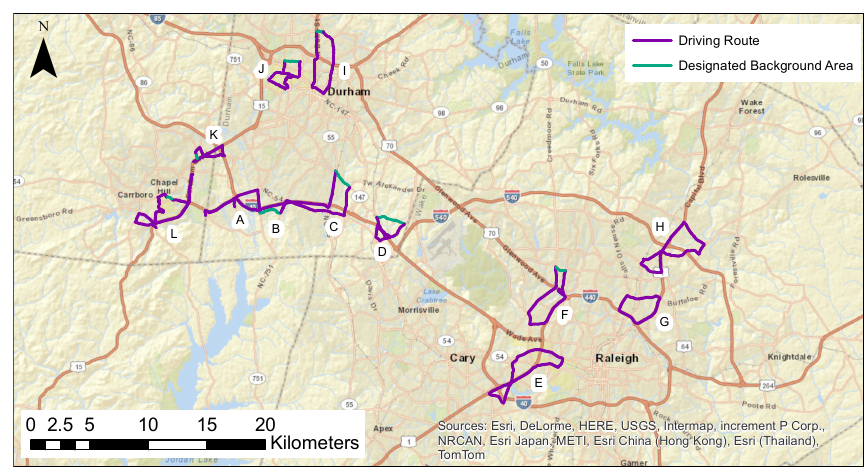
Figure 2. Map of all routes and designated background areas. Background areas were designated for 8 of the 12 routes that had identifiable low-traffic roads distant from known sources. Routes are labeled